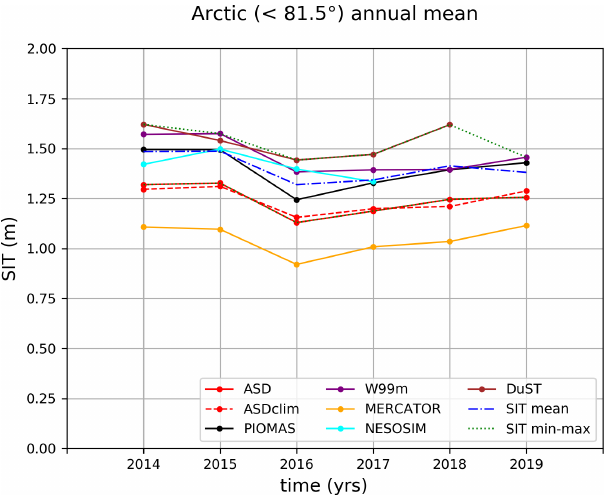
Figure 11. Arctic annual mean time series (2014–2019) of the av- eraged SIT solutions computed using various snow depth products (models and active/passive satellite-based). Spatial coverage is de- fined by the smallest sea ice extent. The dotted blue lines define the annual mean, minimum and maximum values between all solutions (except for MERCATOR). The AMSR2 data are not represented since they are not available over the